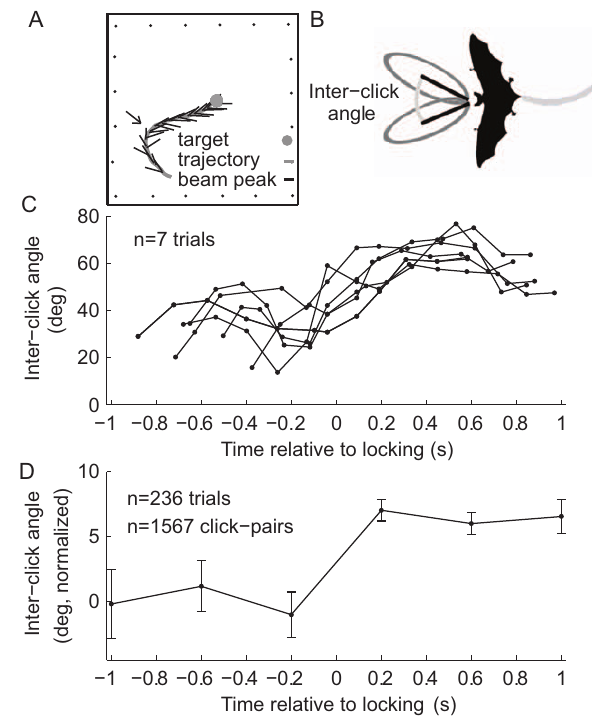
Figure 1. The inter-click beam angle is increased at the moment of locking when the bat is approaching a single object. (A) Schematic of single trial showing flight trajectory and direction of echolocation clicks in an Egyptian fruit bat (black lines). Dots at circumference, microphones; arrow, point of locking onto target. (B) Illustration of the inter-click angle. Black lines, direction of beam’s peak; gray ellipse, polar representation of the sonar beam. (C) Examples of seven trials in which the inter-click angle abruptly increased around time 0 (=the moment of locking). (D) Population average inter-click angle along the bats’ approach to a single object. The angle was normalized separately for each bat to its average un- locked angle (see Materials and Methods). Error bars, mean 6 s.e.m.; computed in 0.4-s bins.